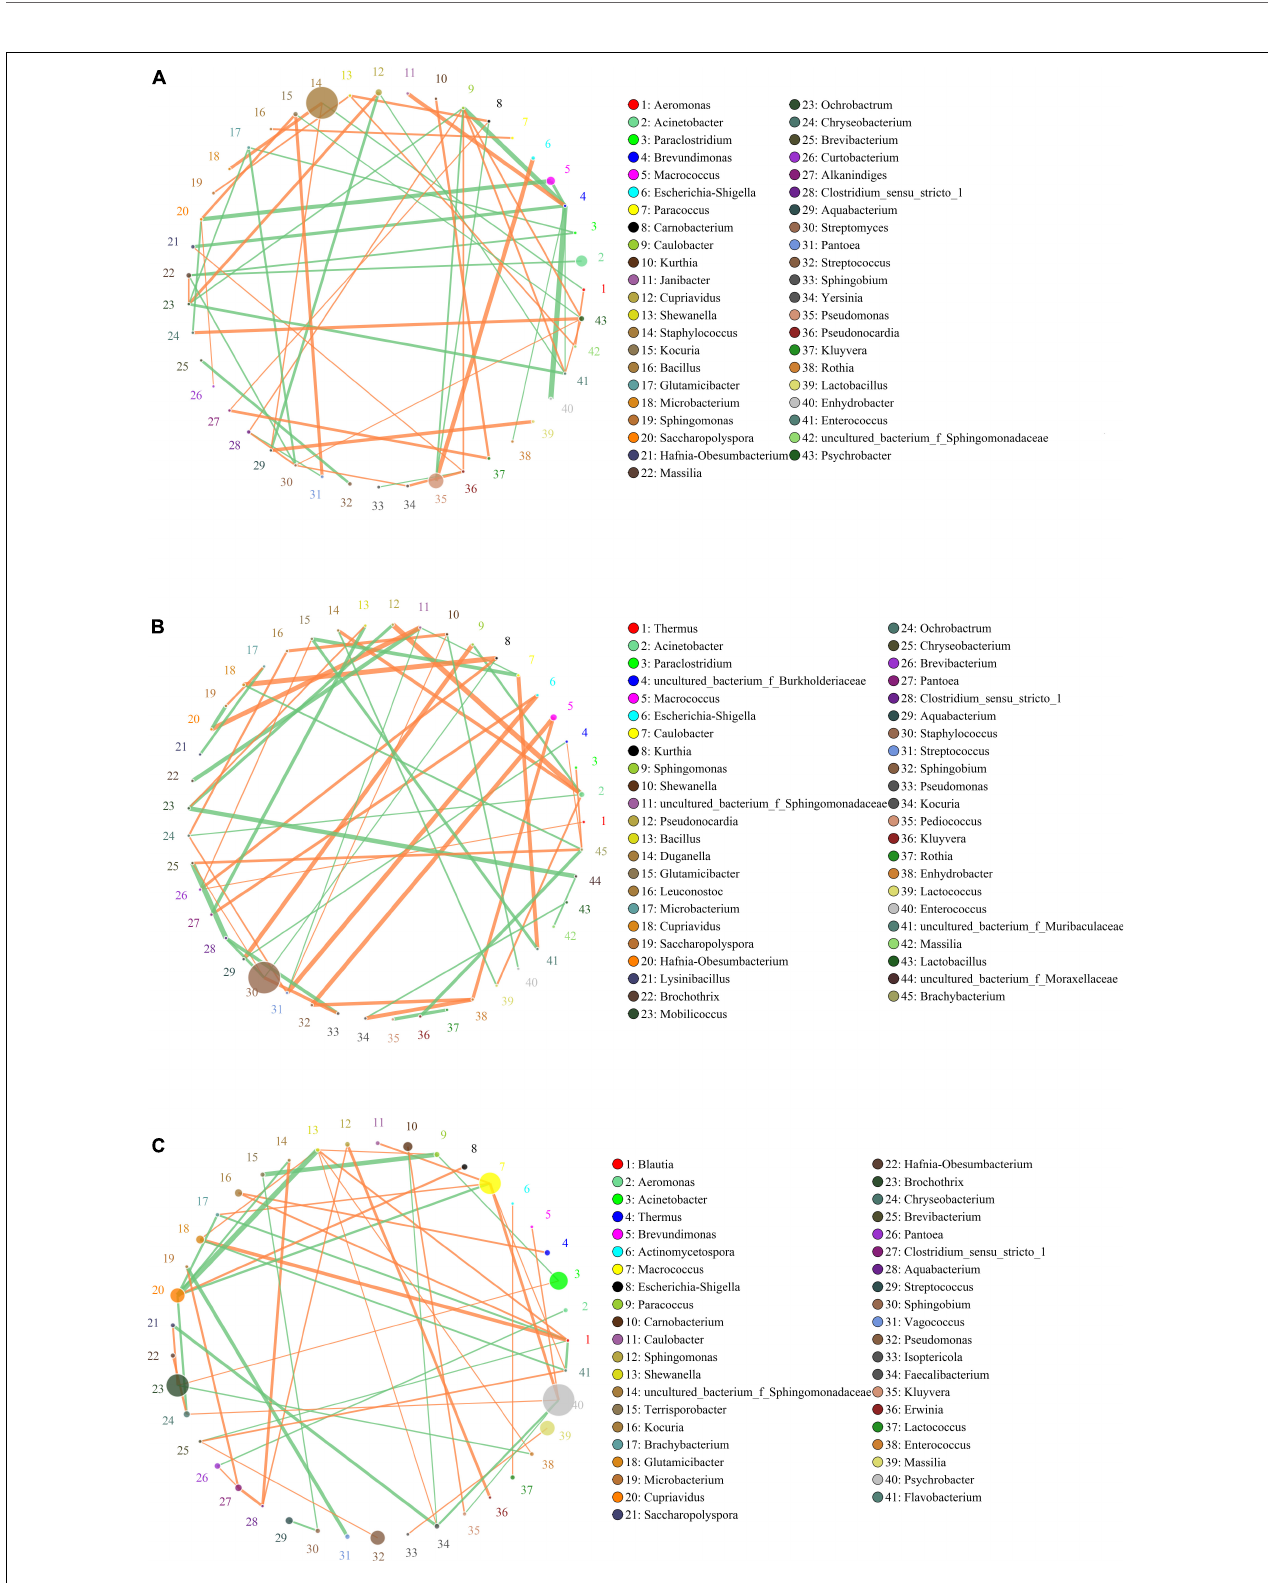
FIGURE 4 | Networks of microbial interaction in the F group (A) , M group (B) and S group (C) . Circle is on behalf of the species, size of the circle represents the abundance. Lines represent the correlation between the two species, line thickness to represent the strength of the correlation, the color of the line: orange represents the positive correlation, green represents the negative